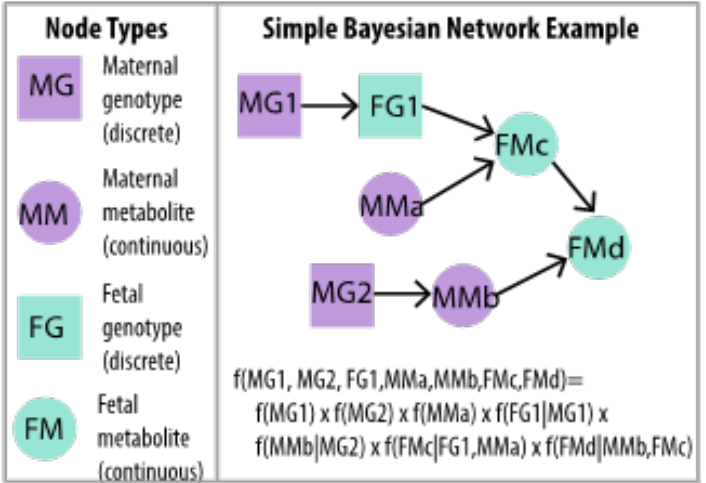
Figure 4. Simple BNM example of two maternal genotypes (MG1, MG2), one fetal genotype at the same locus as one maternal genotype (FG1), two maternal metabolites (MMa, MMb) and two other fetal metabolites (FMc, FMd) in which the full multivariate distribution is written as a product of conditional distributions. Ordered dependencies among maternal and fetal genotypes and metabolites are naturally accommodated in BNM estimation.